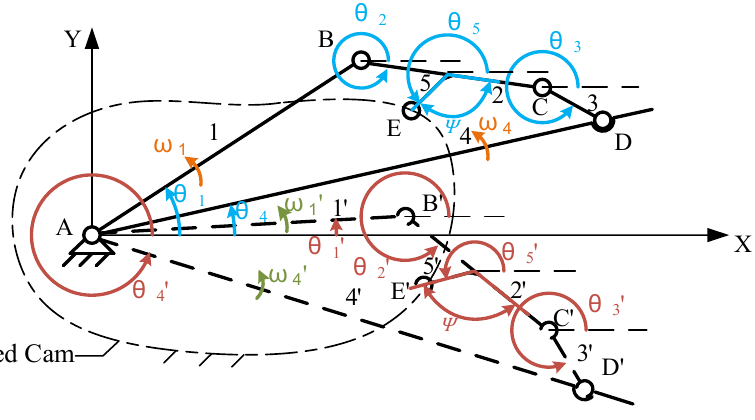
Figure 1 . Schematic diagram of the cam five-bar mechanism. Figure 1. Schematic diagram of the cam five-bar